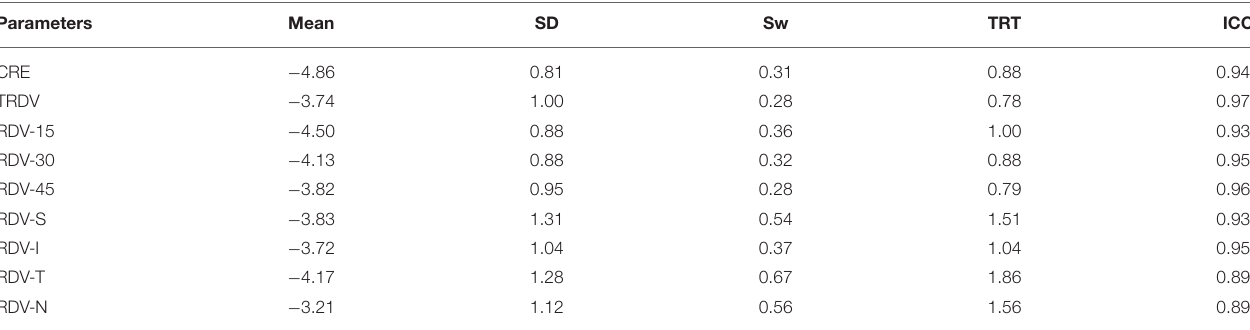
TABLE 7 | Intraobserver repeatability outcomes of central and peripheral refraction using MRT with cycloplegia of moderate myopia group. Parameters